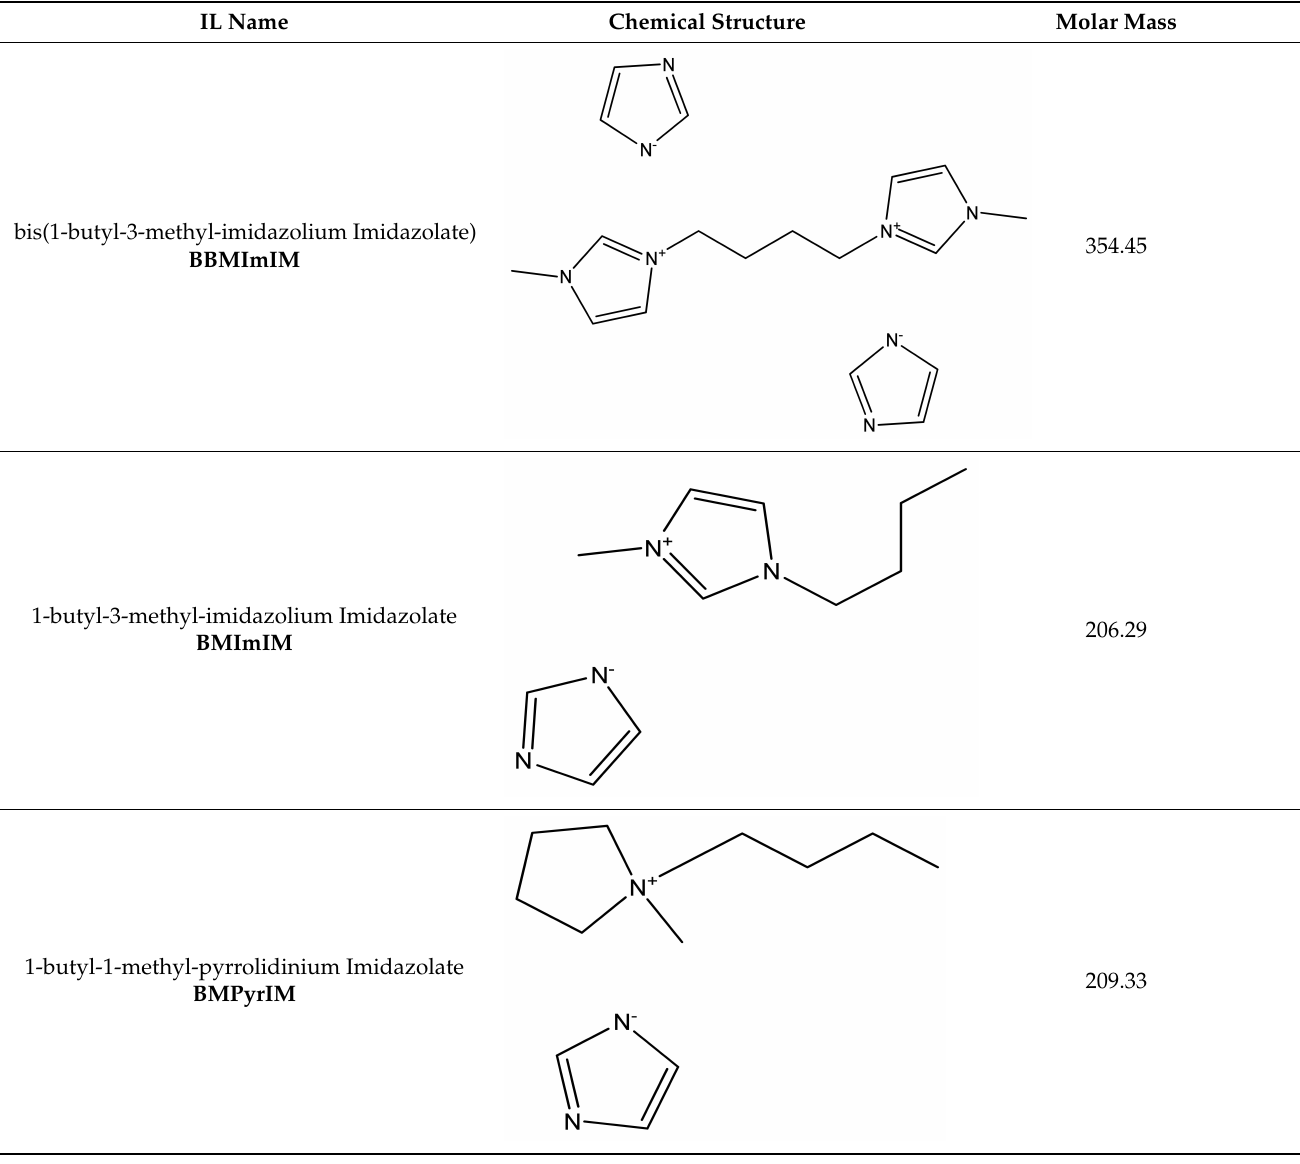
Table 1. The names, chemical structures, and molecular weights of the investigated ionic